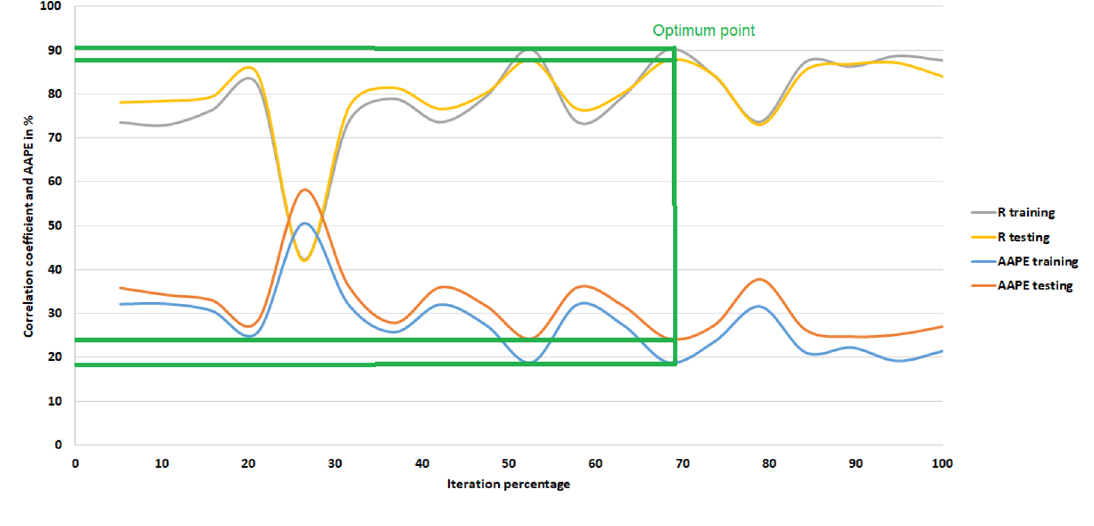
Fig. 10 Results of different iteration in FN